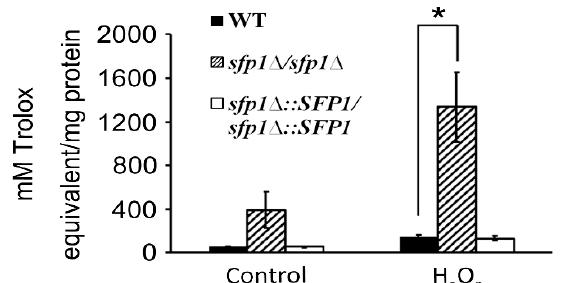
Figure 1. Total antioxidant capacity of C . albicans . The cells were treated with or without 1 mM hydrogen peroxide for 2 h. Total antioxidant capacity was measured and expressed as molar Trolox equivalents. WT: wild-type strain; sfp1 Δ / sfp1 Δ : sfp1 -deleted mutant; sfp1 Δ :: SFP1 / sfp1 Δ :: SFP1 : SFP1 -reintegrated strain. The results are presented as the mean ± standard deviation (SD) of three independent experiments. * P < 0.05.